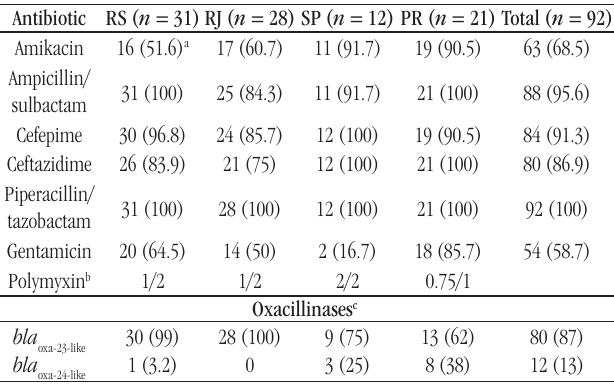
taBLE − Resistance profile and distribution of oxacillinase genes among A. baumannii isolates from four Brazilian